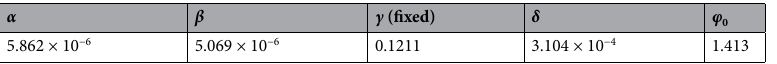
Table 1. Fitting parameters of Eq. (9) based on the data in Fig. 2 (SI